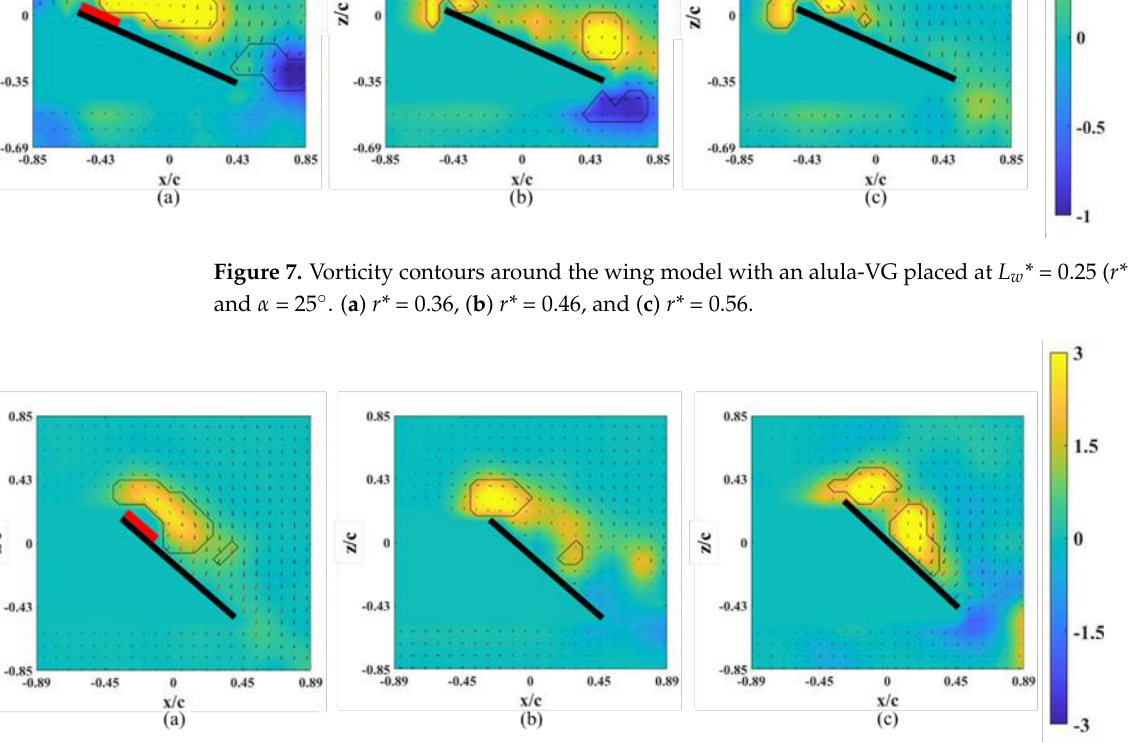
Figure 8. Vorticity contours around the wing model with an alula-VG placed at L w * = 0.25 ( r* = 0.37) and α = 45 ◦ . ( a ) r* = 0.36, ( b ) r* = 0.46, and ( c ) r* = 0.56. The instantaneous snapshots of the vorticity contour on different spanwise planes ( r* = 0.61–0.81) for the wing model on which an alula-VG was placed at L w * =